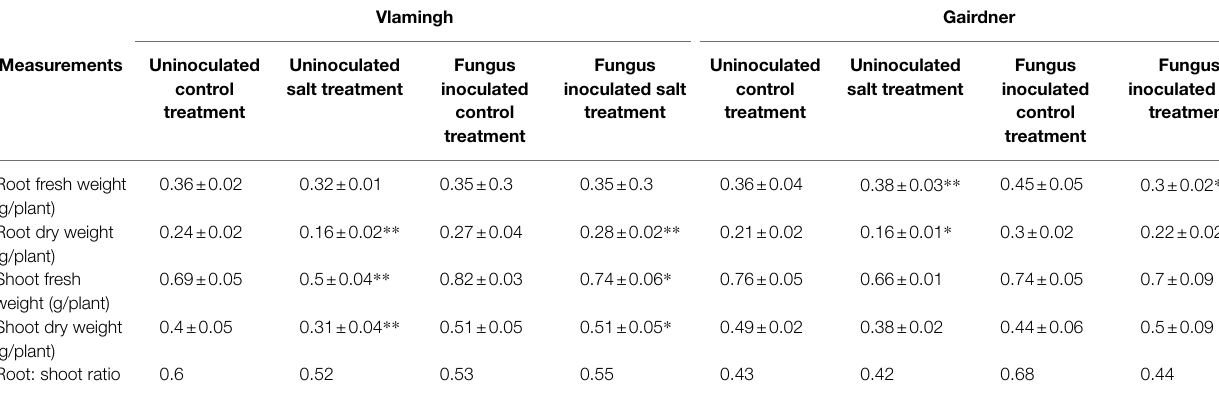
TABLE 2 | Physiological parameters measured in cv. Vlamingh and cv. Gairdner under four treatment